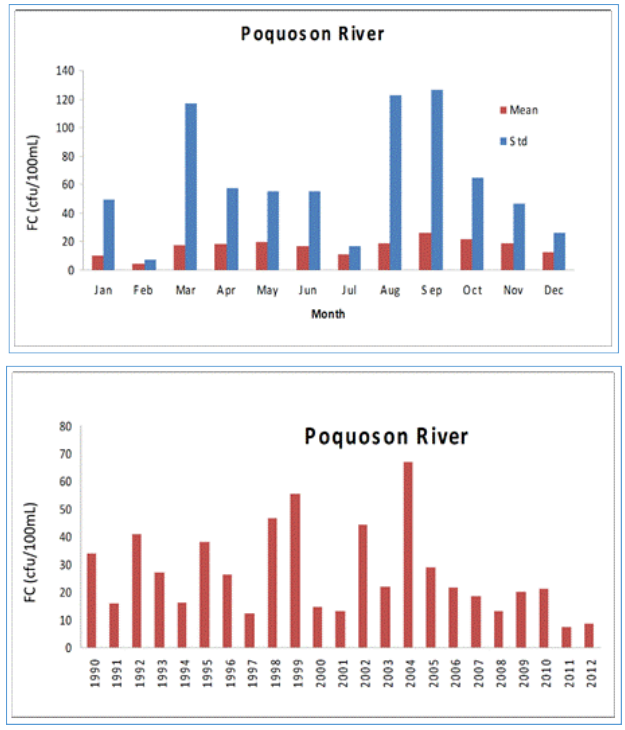
Figure 3. Mean and standard deviation of monthly bacteria distribution ( upper panel ) and annual mean concentration of fecal bacteria ( lower panel ) (1990–2012).